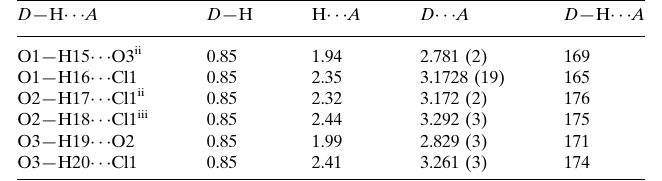
Hydrogen-bond geometry (A˚ , (cid:2)